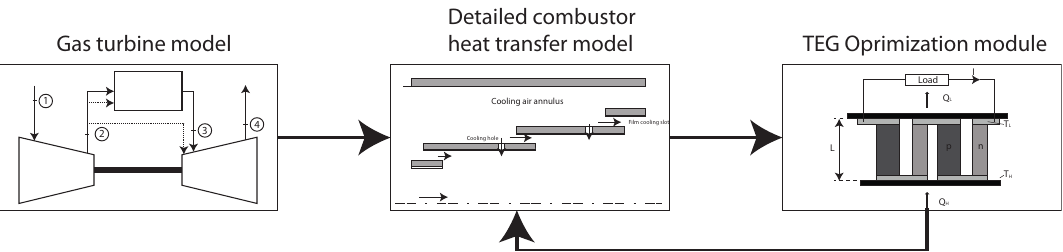
Figure 1. Overview of the applied modeling approach.